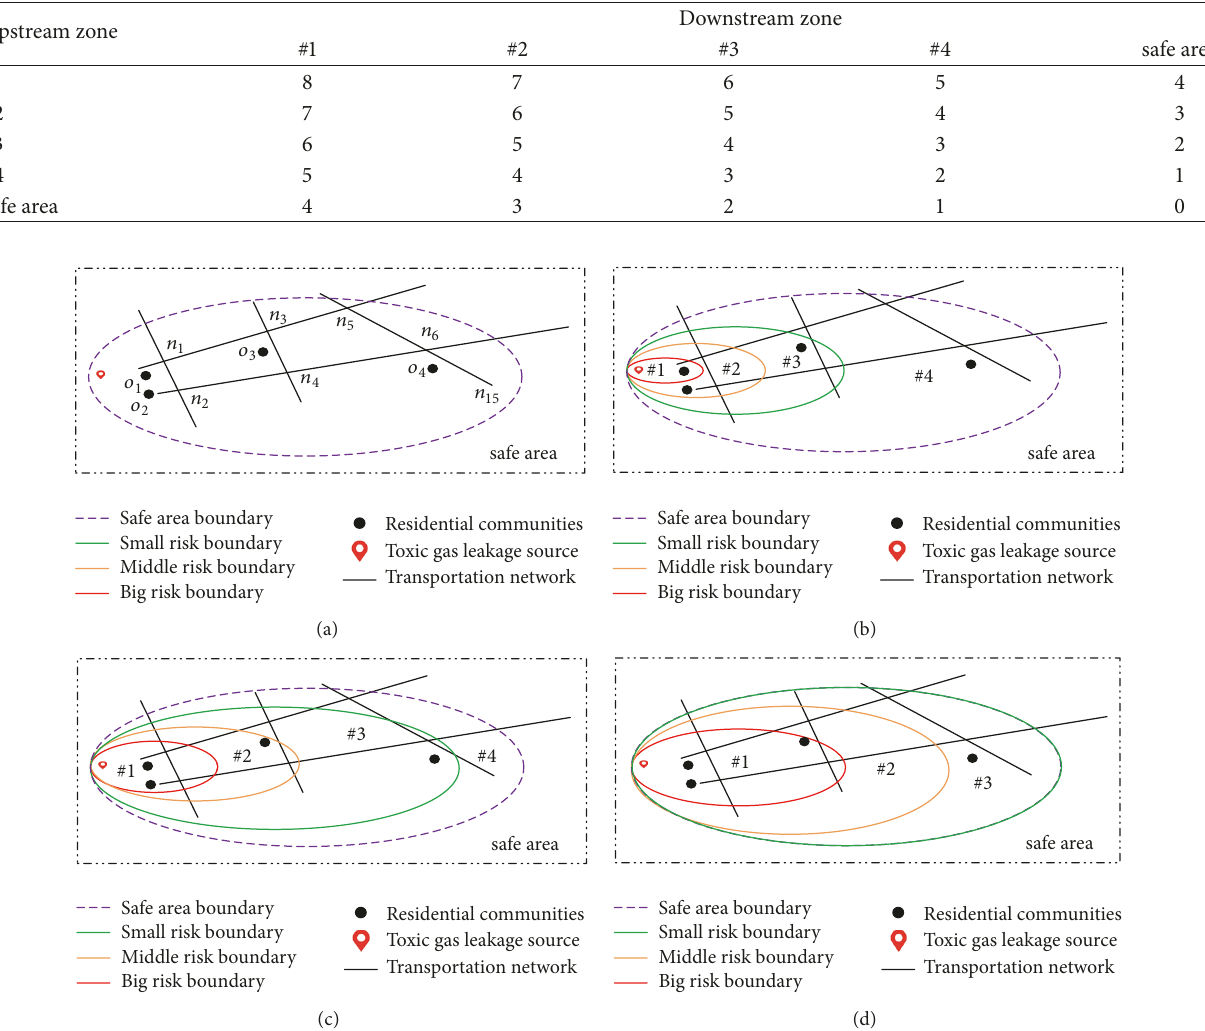
Table 2: Road risk level according to traditional model.